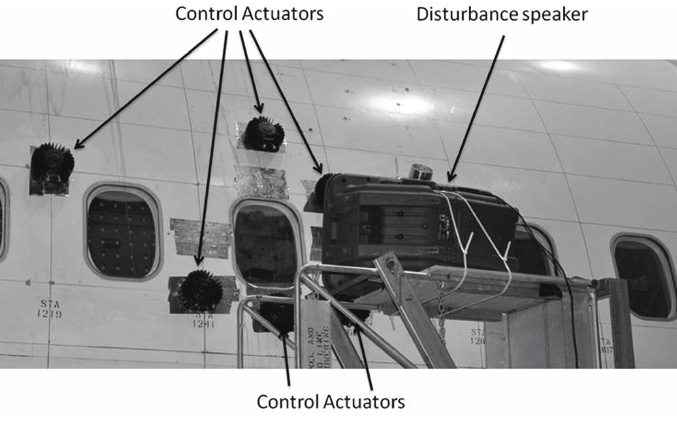
Fig. 11. Photograph of disturbance speaker and control actuators for f1